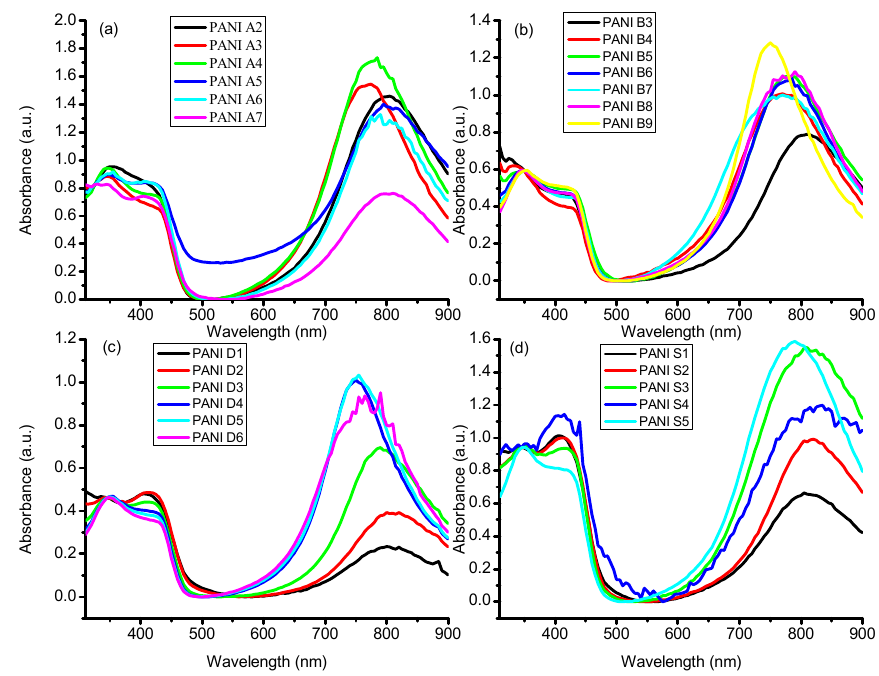
Figure 3. UV/Visible Spectra of different PANI samples indicated in Tables 1–4. ( a ) Monomer optimized samples ( b ) Oxidant optimized samples ( c ) DBSA optimized samples ( d ) Solvents optimized samples.